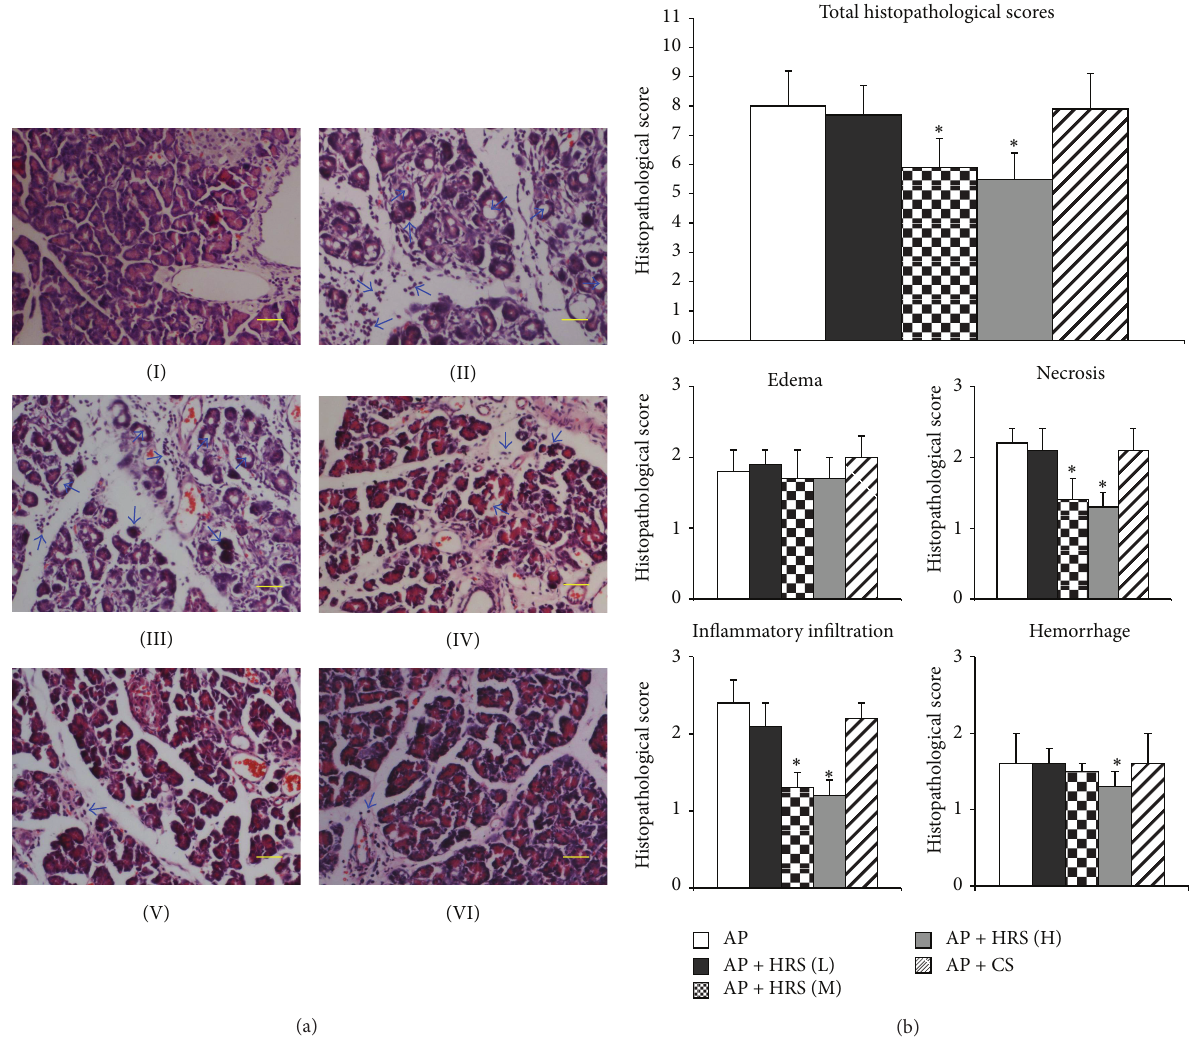
Figure 4: Histopathological examination of pancreatic tissue from mice. The HRS at various doses or control saline (CS) was injected intraperitoneally to AP mice 1h after the final injection of cerulein, respectively. One hour later, animals in each group ( 𝑛 = 6 ) were killed and the pancreatic tissue samples were immediately collected. After fixed in formaldehyde and embedded in paraffin, the samples were sectioned and stained with hematoxylin and eosin, using a standard staining procedure. Histopathological evaluation was performed under light microscope and the scores were calculated according to histopathological changes including edema, inflammatory infiltration, hemorrhage, and necrosis. (a) Images of histological sections; I: sham; II: AP model group; III: AP + CS; IV: AP + HRS (L); V: AP + HRS (M); VI: AP + HRS (H); scale bars = 50 𝜇 m. Significant histopathological changes like cytoplasmic vacuole generation, inflammatory cells infiltration, and parenchyma necrosis were indicated by blue arrows. (b) Histopathological scores. ∗ 𝑃 < 0.05 , compared with AP